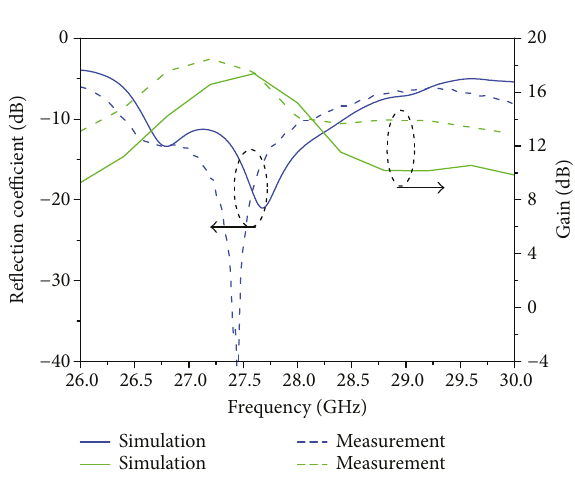
Figure 8: The simulated and measured S